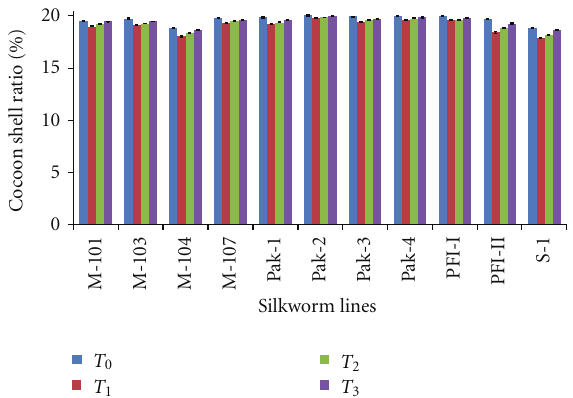
Figure 8: Comparative performance of cocoon shell ratio (mean ± SE) of eleven silkworm lines at 30 ± 1 ◦ C in combination with 55, 65, and 75% RH and controlled conditions of temperature and RH (25 ± 1 ◦ C and 70–80%, resp.).